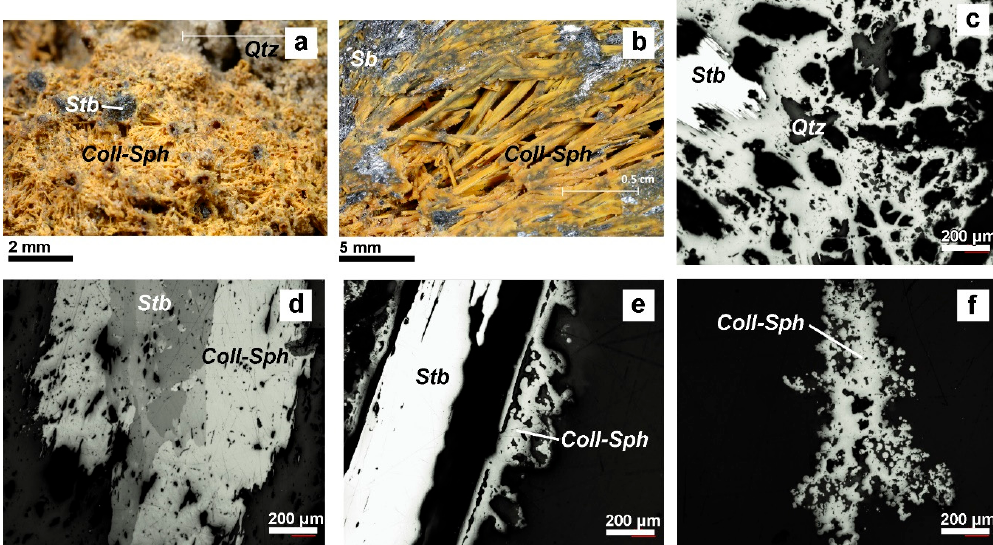
Figure 5. Macroscopic and reflected light images: ( a,b ) colloform sphalerite (Coll-Sph), quartz (Qtz), and stibnite (Stb); ( c,e ) stibnite (Stb) and colloform sphalerite (Coll-Sph) parallel polarizers; ( d ) stibnite (Stb) and colloform sphalerite (Coll-Sph) crossed polarizers; ( f ) earthy aggregates of colloform sphalerite (Coll-Sph) parallel polarizers.